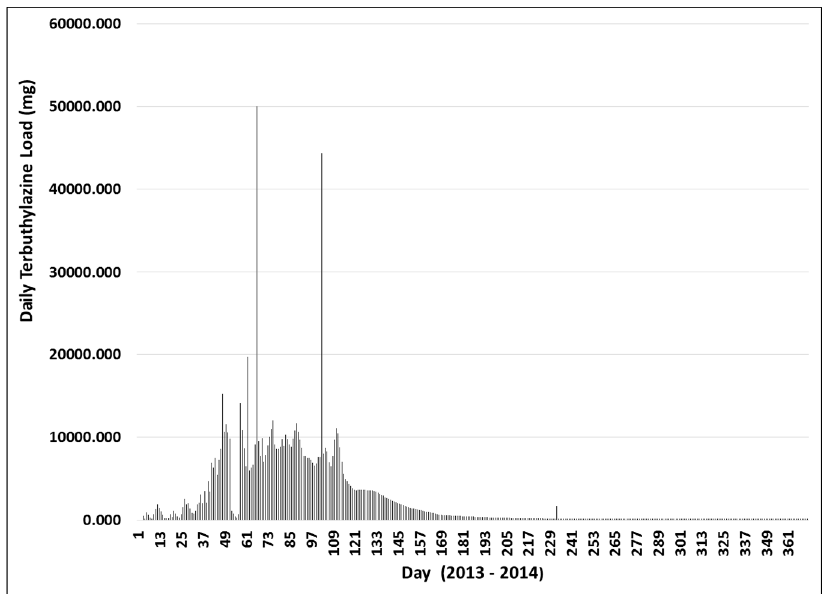
Figure 18. Year 2—daily loadings of terbuthylazine at the Rangitaiki flow gauge.